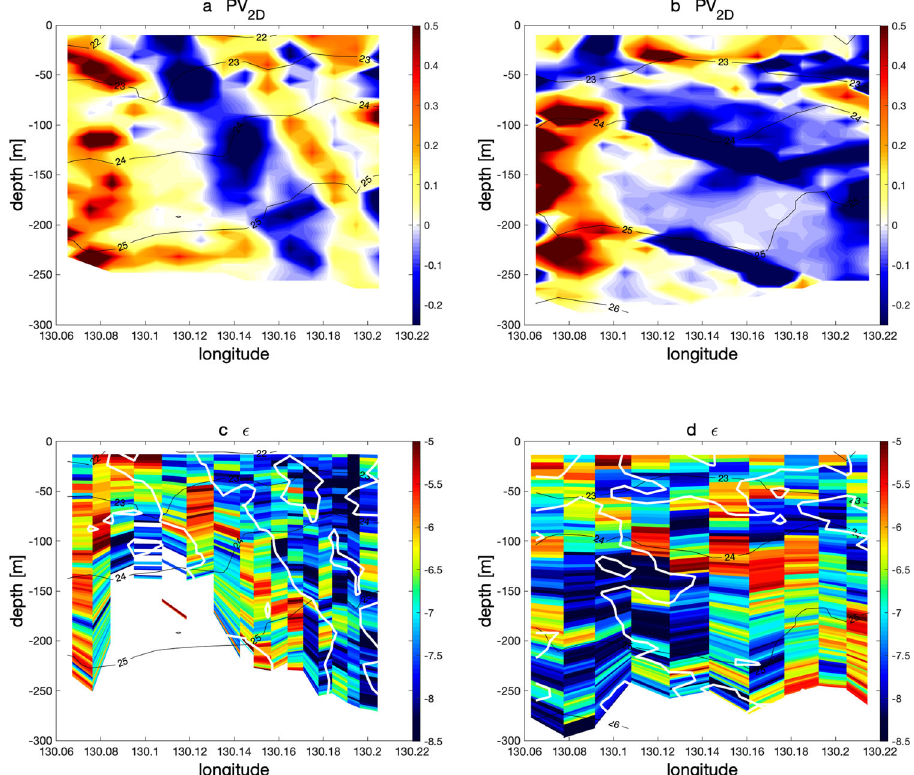
Fig. 5 Observed two-dimensional potential vorticity and dissipation rates during June 2018 cruise. The vertical section of the two-dimensional potential vorticity PV 2D (10 – 8 m – 1 s – 1 ) computed with the geostrophic vertical shear (Eq. (4) in “ Methods ” ) around Hirase submarine rise is shown in ( a , b ), and the measured turbulent kinetic energy dissipation rates (log 10 W kg − 1 ) are shown in ( c , d ). The vertical sections in ( a , c ) are along the red line in Fig. 4, and those in ( b , d ) are along the blue line in Fig. 4. Contours in ( a – d ) represent isopycnals. The white contours in ( c , d ) are at PV = 0.